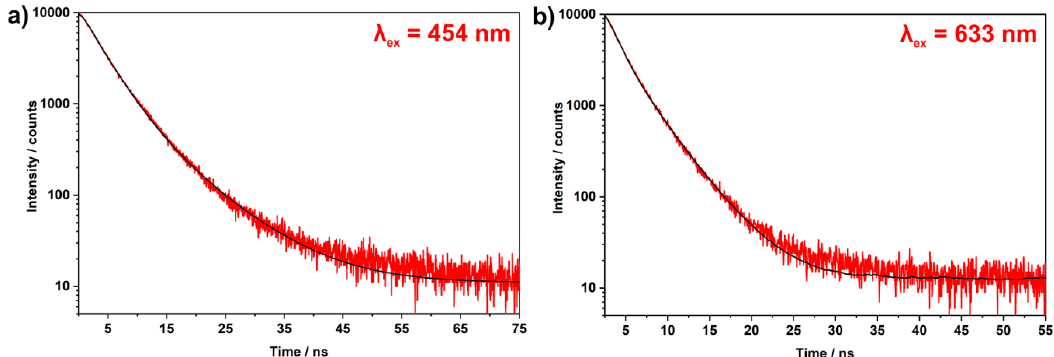
Figure 7. Fluorescence lifetimes of the as-prepared C-dots for the deep-red emission at 715 nm for ( a ) excitation at 454 nm and ( b ) excitation at 633 nm.